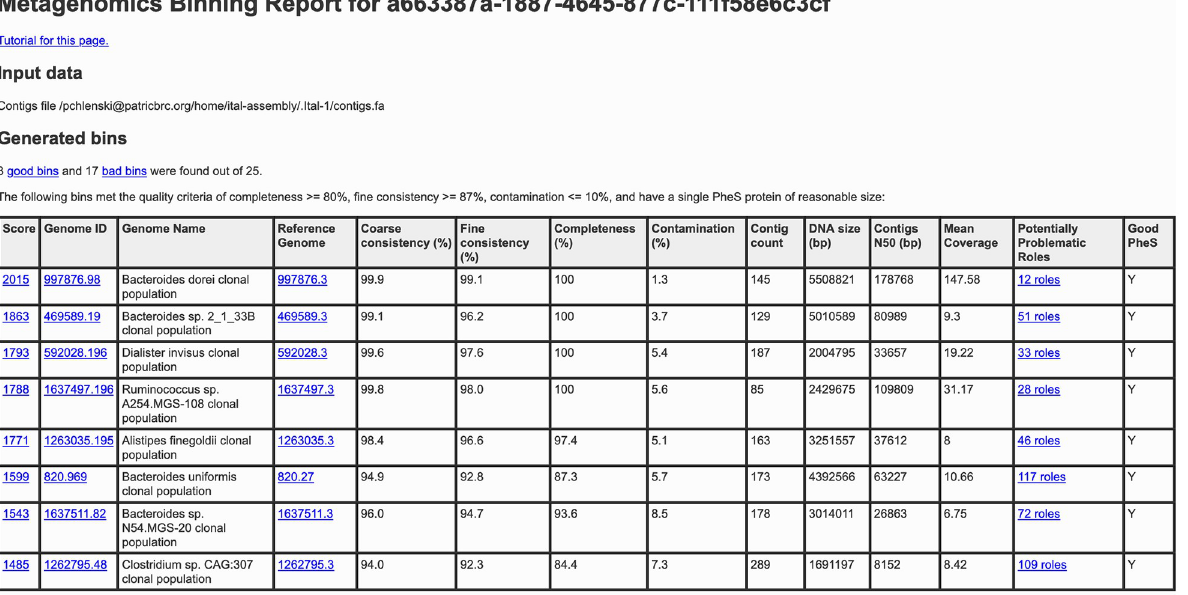
Fig 2. Metagenomic binning report for high-quality bins. The first part of the generated binning report summarizes the inputs, total number of bins, and quality breakdown of the bins. For high-quality bins, it reports the overall score, genome ID (with link to PATRIC genome page), organism name (ending in “clonal population”), a link to the reference genome used in the binning process, and a number of quality metrics including a link to the problematic roles report.